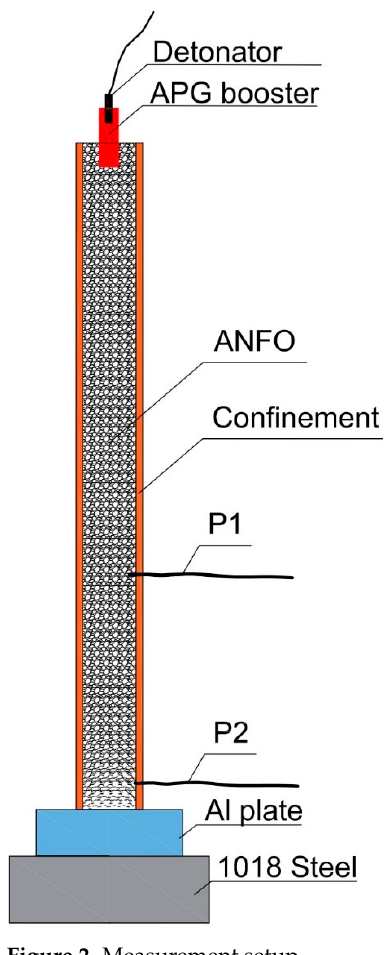
Figure 2. Measurement setup.